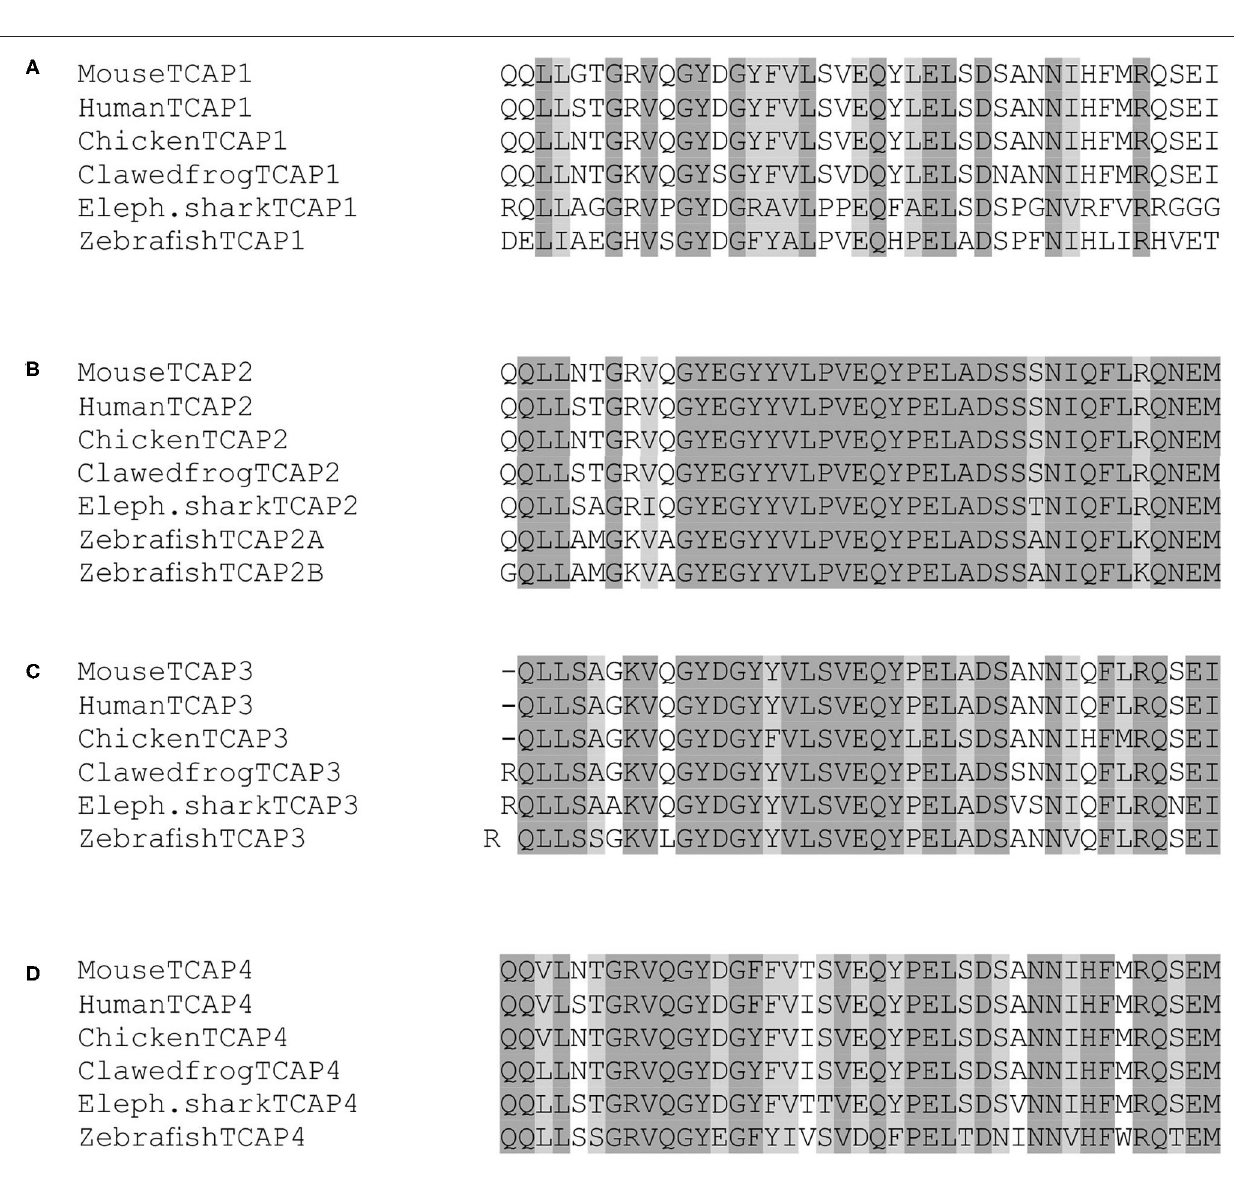
FIGURE 2 | Multiple sequence alignment TCAP family members among various species. (A) TCAP-1; (B) TCAP-2; (C) TCAP-3; (D) TCAP-4. The mature peptide sequences were aligned using MUSCLE (Multiple Sequence Comparison by Log-Expectation). Dark gray boxes indicate amino acid identity and light gray boxes indicate a functional